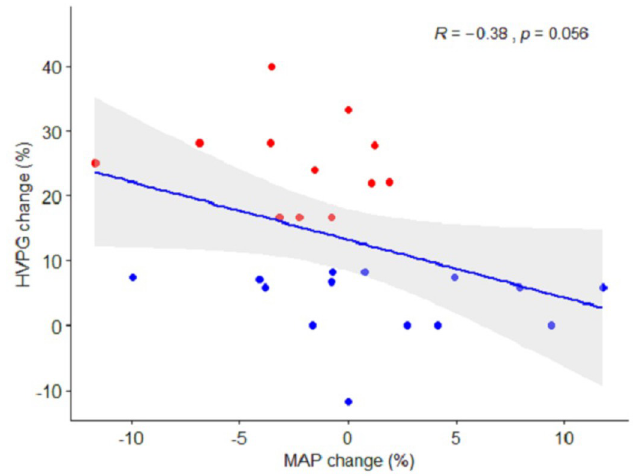
Fig 4. Correlation between changes in portal pressure and mean arterial pressure. The impact of beta-blockers on mean arterial pressure in relation to the beta-blocker response on portal pressure. The grey area indicates a 95% confidence interval. Red plots: patients classified as responders. Blue plots: patients classified as non-responders.